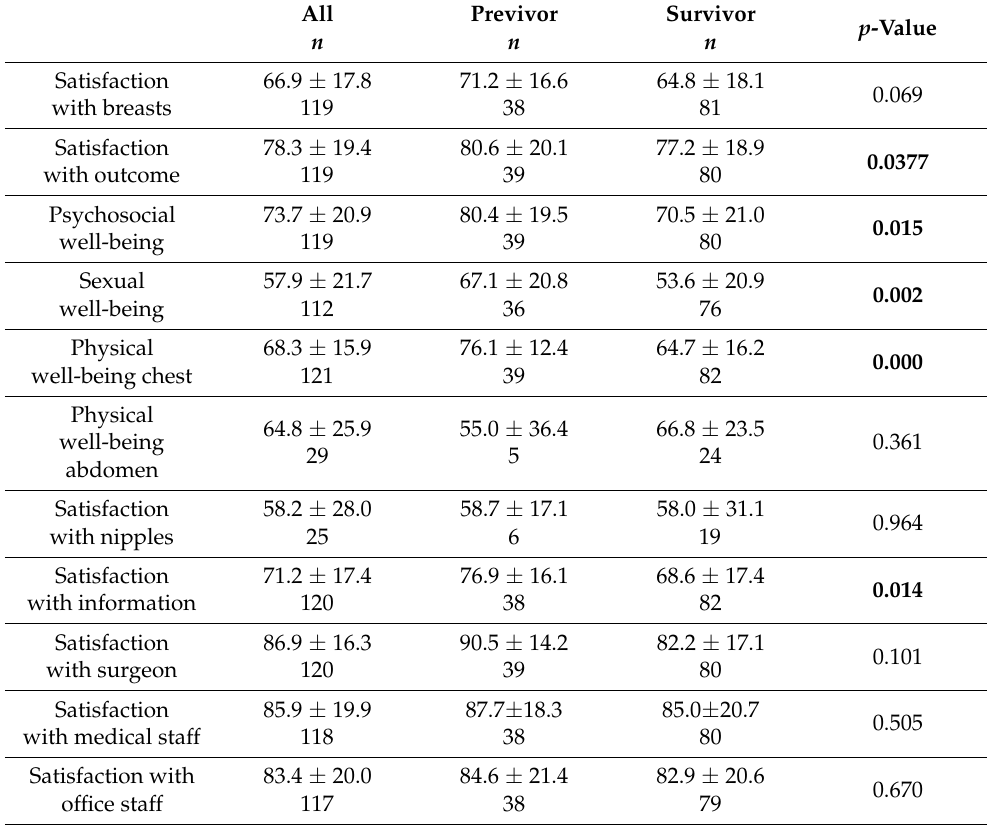
Table 3. BREAST-Q Scores of the reconstruction module of all probands, previvors, and survivors. Values are presented as mean ± SD with consort diagram. n = number of participants with valid answers. Results in bold are statistically significant ( p <